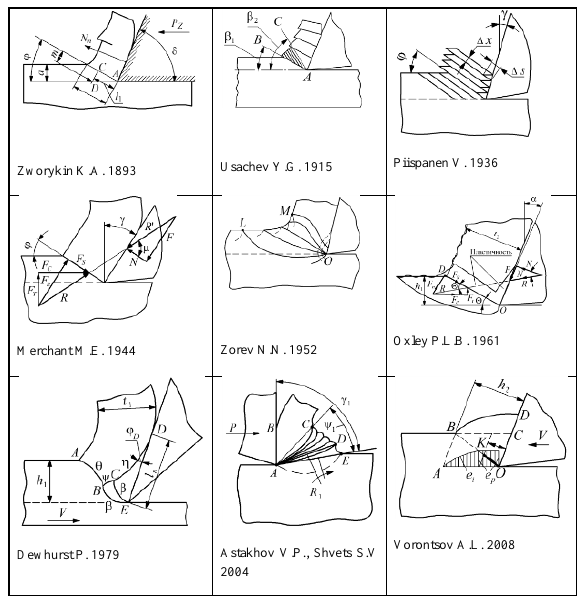
Table 1. Cutting models and